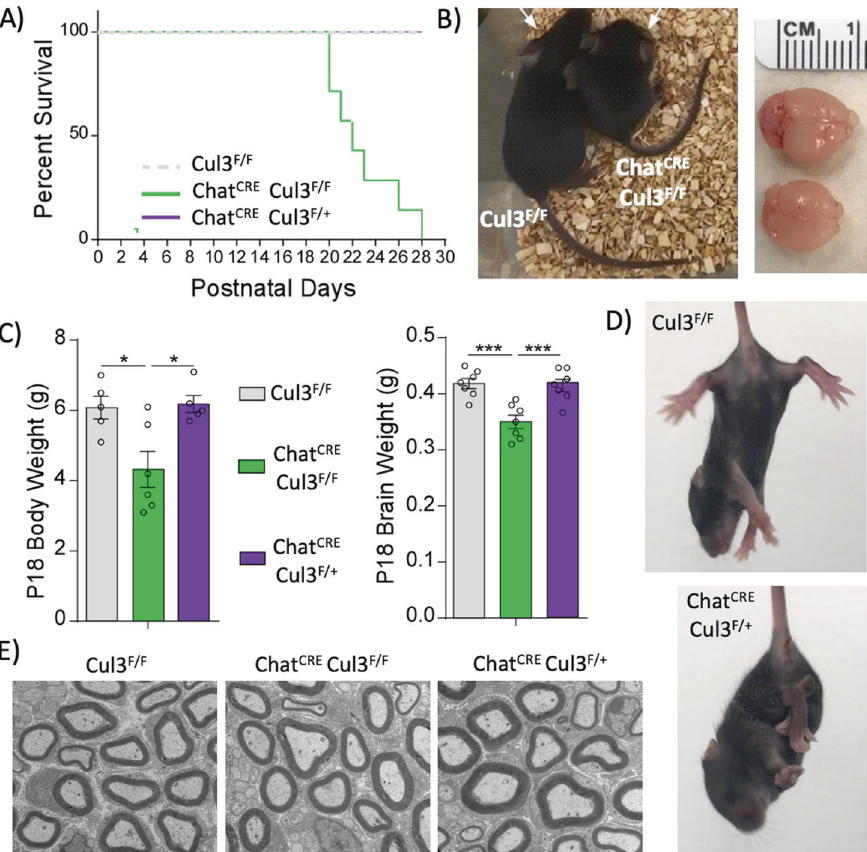
Fig. 1 Early postnatal effects of Cul3 de fi ciency in cholinergic neurons. A Kaplan-Meier survival curve of the different genotypes showing the postnatal lethality of mice caused by biallelic Cul3 knockout in cholinergic neurons ( χ 2 (2) = 38.51, p < 0.001; Cul3 F/F : n = 16, Chat CRE Cul3 F/F : n = 13, Chat CRE Cul3 F/ + : n = 17). B Representative images of visual differences in body and brain sizes between a Cul3 F/F mouse and a Chat CRE Cul3 F/F sibling. C Differences in body (left) and brain (right) weight across the genotypes at postnatal day p18 (Body weight: F(2,13) = 7.18, p = 0.008, one-way ANOVA, Cul3 F/F : n = 5, Chat CRE Cul3 F/F : n = 6, Chat CRE Cul3 F/ + : n = 5; Brain weight: F(2,18) = 13.94, p = 0.0002, one-way ANOVA, n = 7 mice/genotype). Tukey ’ s post-hoc test was used for multiple comparisons. * p < 0.05; *** p < 0.001. D Clenching phenotype in Chat CRE Cul3 F/ + mice (bottom) that is absent in wild-type littermates. E Representative pictures of transmission electron microscopy of sciatic nerves across the different genotypes, showing no evident